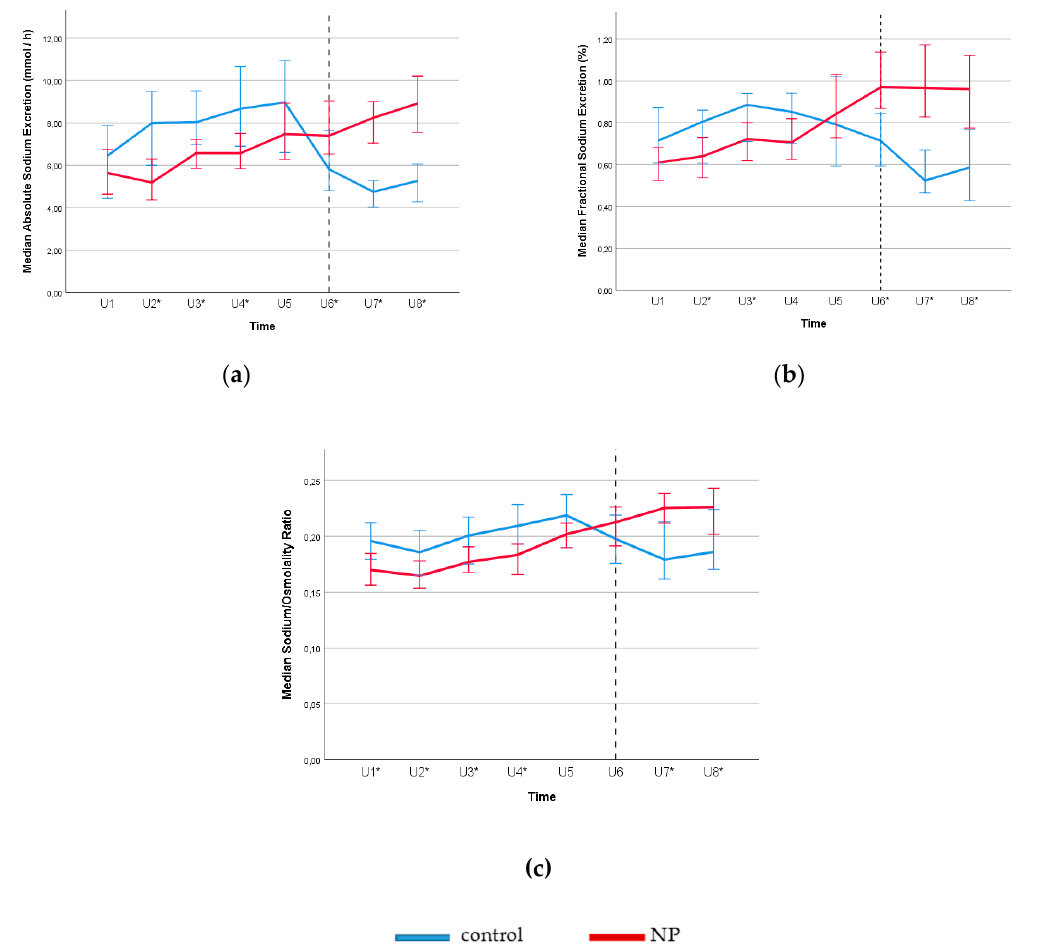
Figure 3. Circadian rhythms for absolute sodium excretion ( a ), fractional sodium excretion ( b ) and sodium / osmolality ratio ( c ) for subjects with and without NP (control) according to eight urine samples collected over 24 h. Reference line separates the day and night time. Daytime urine samples were collected between 8–11 a.m. (U1), 11 a.m.–2 p.m. (U2), 2–5 p.m. (U3), 5–8 p.m. (U4), and 8–11 p.m. (U5). Nighttime urine samples were taken at 11 p.m.–2 a.m. (U6), 2–5 a.m. (U7), and 5–8 a.m. (U8). * p < 0.05 for NP versus the control group (Mann–Whitney U test). Error bars: 95% CI. Note: Subjects with NP shows increased sodium excretion throughout the night, which shows the loss of circadian rhythm in renal handling of sodium in osmotic